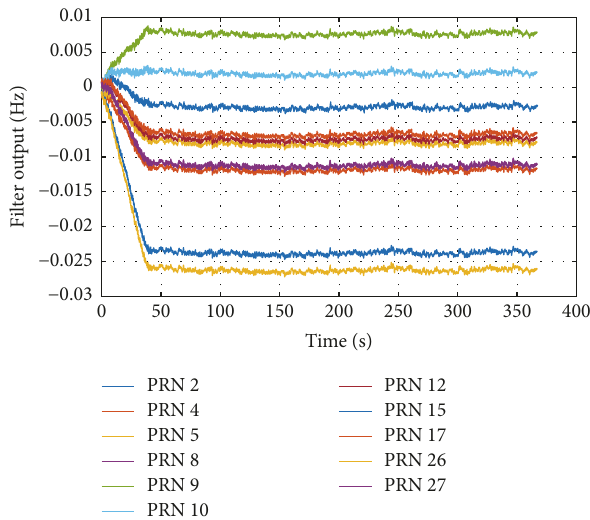
Figure 4: PLL filter output in the conventional GNSS receiver.